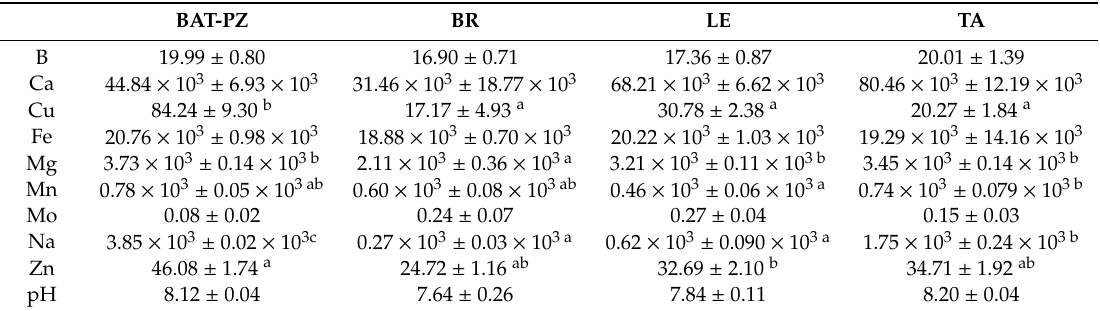
Table 1. Means (mg kg − 1 ) ± standard error of the mean (SEM) obtained for the ionomic content of soil samples from di ff erent olive farm. Tukey Honestly Significant Di ff erence (HSD) test was applied for multiple comparisons of groups (provinces). BAT: Barletta-Andria-Trani; LE, BR, TA: Lecce, Brindisi,